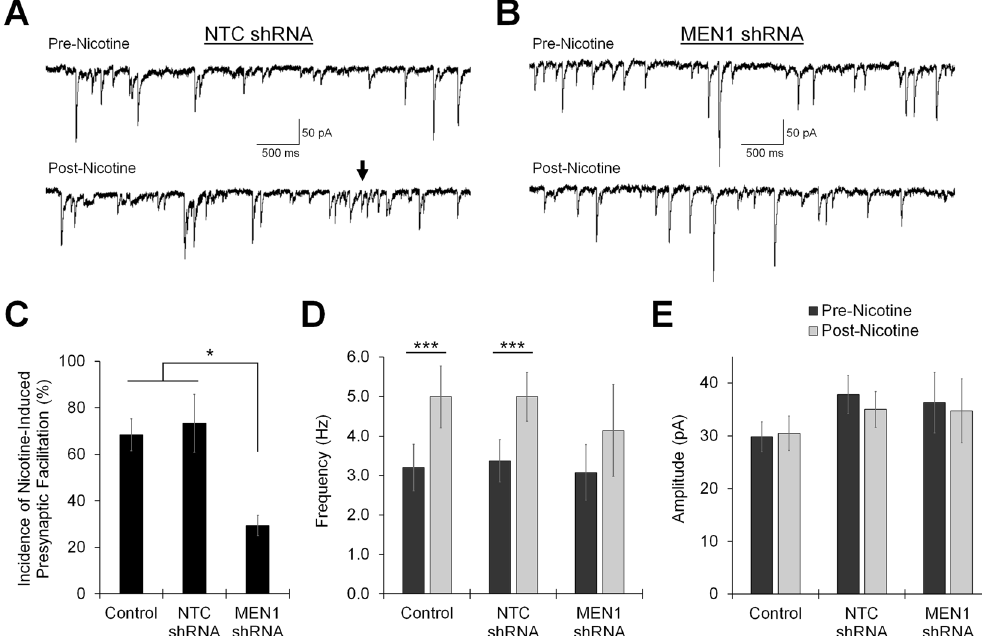
Figure 8. Menin knockdown reduces nicotine-induced presynaptic facilitation. ( A , B ) Representative patch clamp traces recorded from GFP + hippocampal pyramidal neurons at DIV 10–14 (n ≥ 15, 3 independent experiments, representative traces). The mean frequency and amplitude of mEPSCs was analyzed before (Pre- nicotine, 10 s; top trace) and after (Post-nicotine, 10 s; bottom trace) the nicotine pulse (10 μ M, 250 ms, 10 PSI; not shown). nAChR-mediated increase in mEPSC frequency (e.g. arrow) is observed in a GFP + neuron from NTC-shRNA expressing cultures ( A ), but is absent in a GFP + neuron from MEN1 -shRNA expressing cultures ( B ). ( C ) Summary data, incidence of nicotine-induced presynaptic facilitation in neurons from untreated control (n = 13/19), NTC shRNA (n = 11/15; GFP + ) and MEN1 shRNA (n = 5/17; GFP + ) transduced hippocampal cultures (post/pre-nicotine relative mEPSC frequency ≥ 1 ± SEM; see Fig. S5 and Table S8). * Statistical significance (Chi-squared test), P < 0.05. ( D ) Summary data, mean frequency of mEPSCs before (pre) and after (post) the nicotine pulse in the population of neurons from untreated control (n = 13), NTC shRNA (n = 11; GFP + ) and MEN1 shRNA (n = 5; GFP + ) transduced cultures that exhibit nicotine-induced presynaptic facilitation. *** Statistical significance (paired t-test) , P < 0.001. ( E ) Summary data, mean amplitude of mEPSCs, as in ( D ). See also Tables S7–S9 and Figs